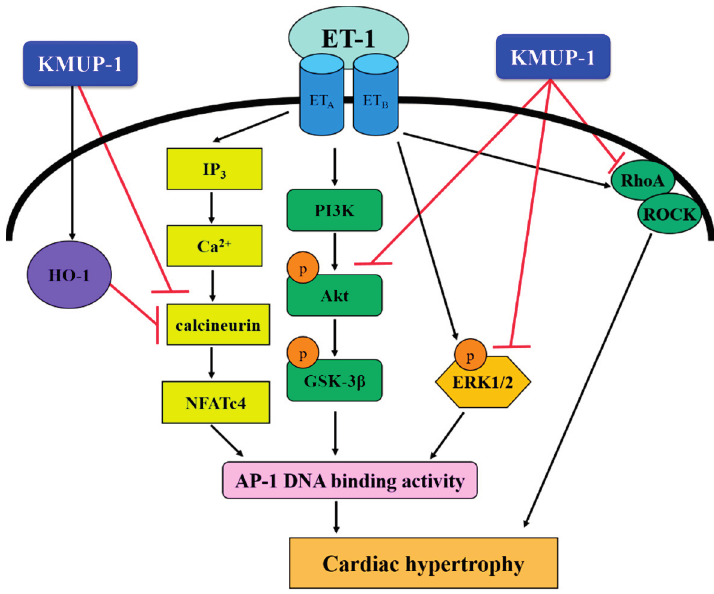
Figure 9. Proposed signaling pathways involved in the protective effects of KMUP-1 on ET-1-induced cardiomyocyte hypertrophy. The underlying mechanisms are associated with inhibition of p-ERK1/2, p-Akt, p-GSK-3 β , calcineurin A, nuclear NFATc4 expression and Rho A translocation, subsequent AP-1 expression and up-regulation of